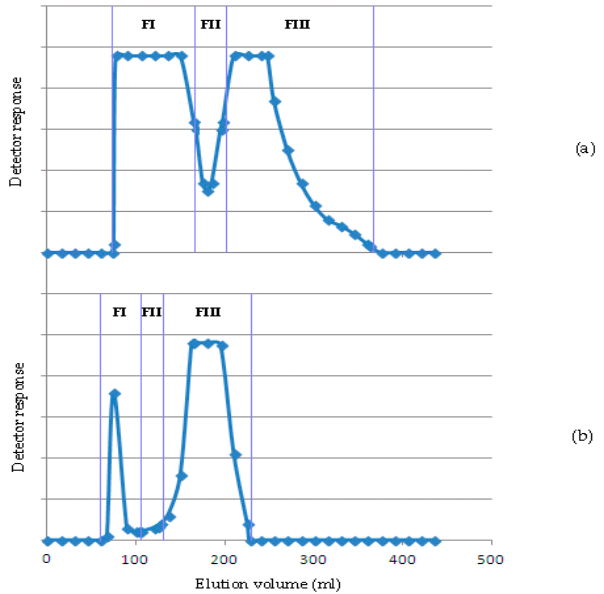
Figure 1. Sepharose CL-4B chromatography of ( a ) KOH-extracted hemicellulosic extract (S4); and ( b ) NaOH-extracted hemicellulosic extract (S5).